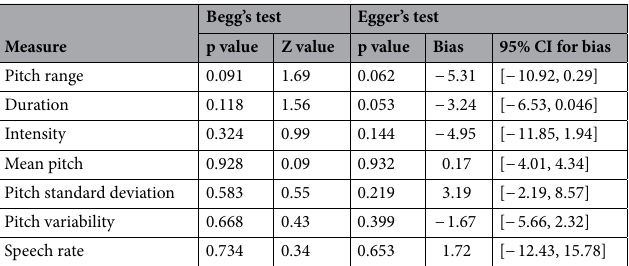
Table 7. Results for assessing publication bias using the Begg’s and Egger’s tests for included studies for different acoustic